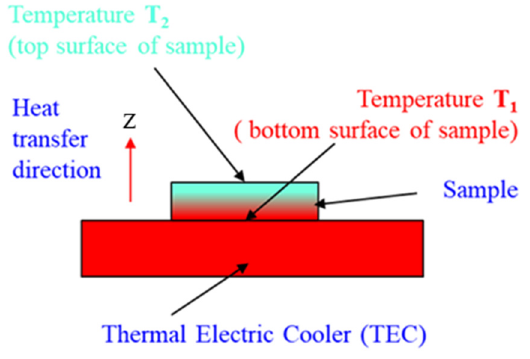
Figure 1. Illustration of thermal conduction in one direction of z-axis.